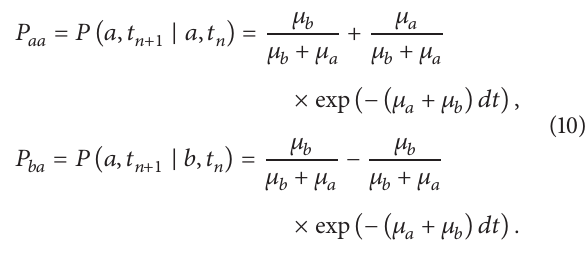
and the noise intensity. Also the conditional probabilities 𝑃 𝑎𝑎 and 𝑃 𝑏𝑎 can also be computed as